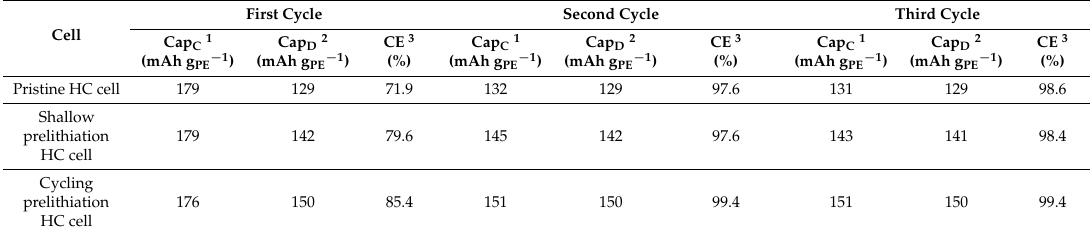
Figure 5. Charge-discharge behaviors of the full-cells with pristine and prelithiated HC NEs during pre-cycling: ( a ) pristine HC cell; ( b ) shallow prelithiation HC cell; ( c ) cycling prelithiation HC cell. The cell voltage was increased from the OCV to 4.2 V for the first charging, and was decreased to 2.5 V for the first discharging. Subsequently, the cells were charged and discharged in the cell voltage range of 2.5–4.2 V. The current density was 0.1 C-rate; 1 C-rate is equal to 170 mA g PE − 1 . Table 2. Specific charge and discharge capacities and CE of NCM/HC full-cells in the first to third cycles at 0.1 C-rate (17 mA g PE − 1